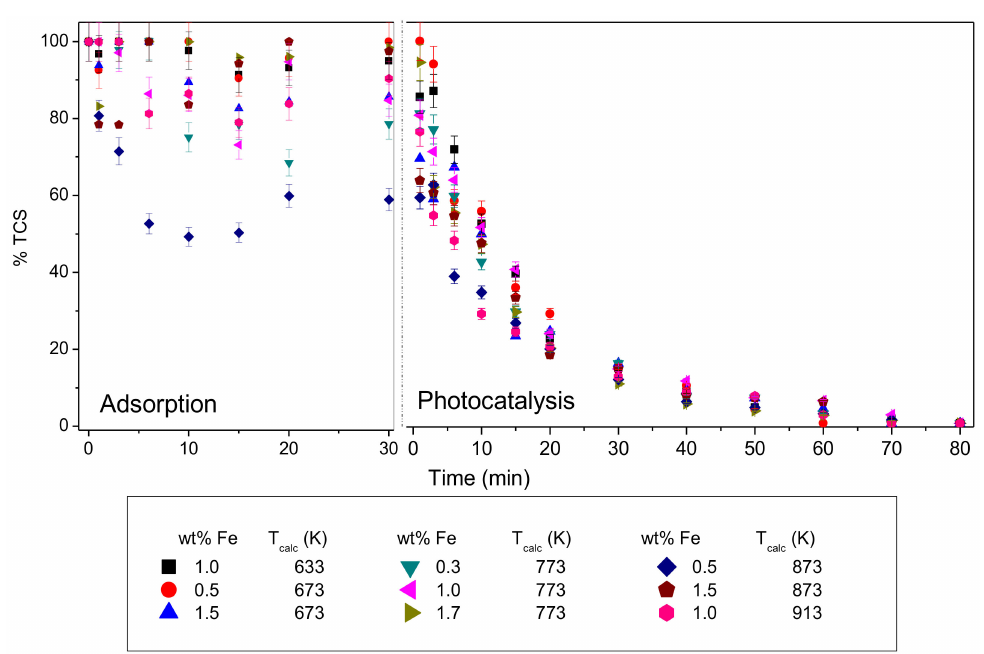
Figure 5. Adsorption and photo catalysis results (pH = 7.0, 1 g L − 1